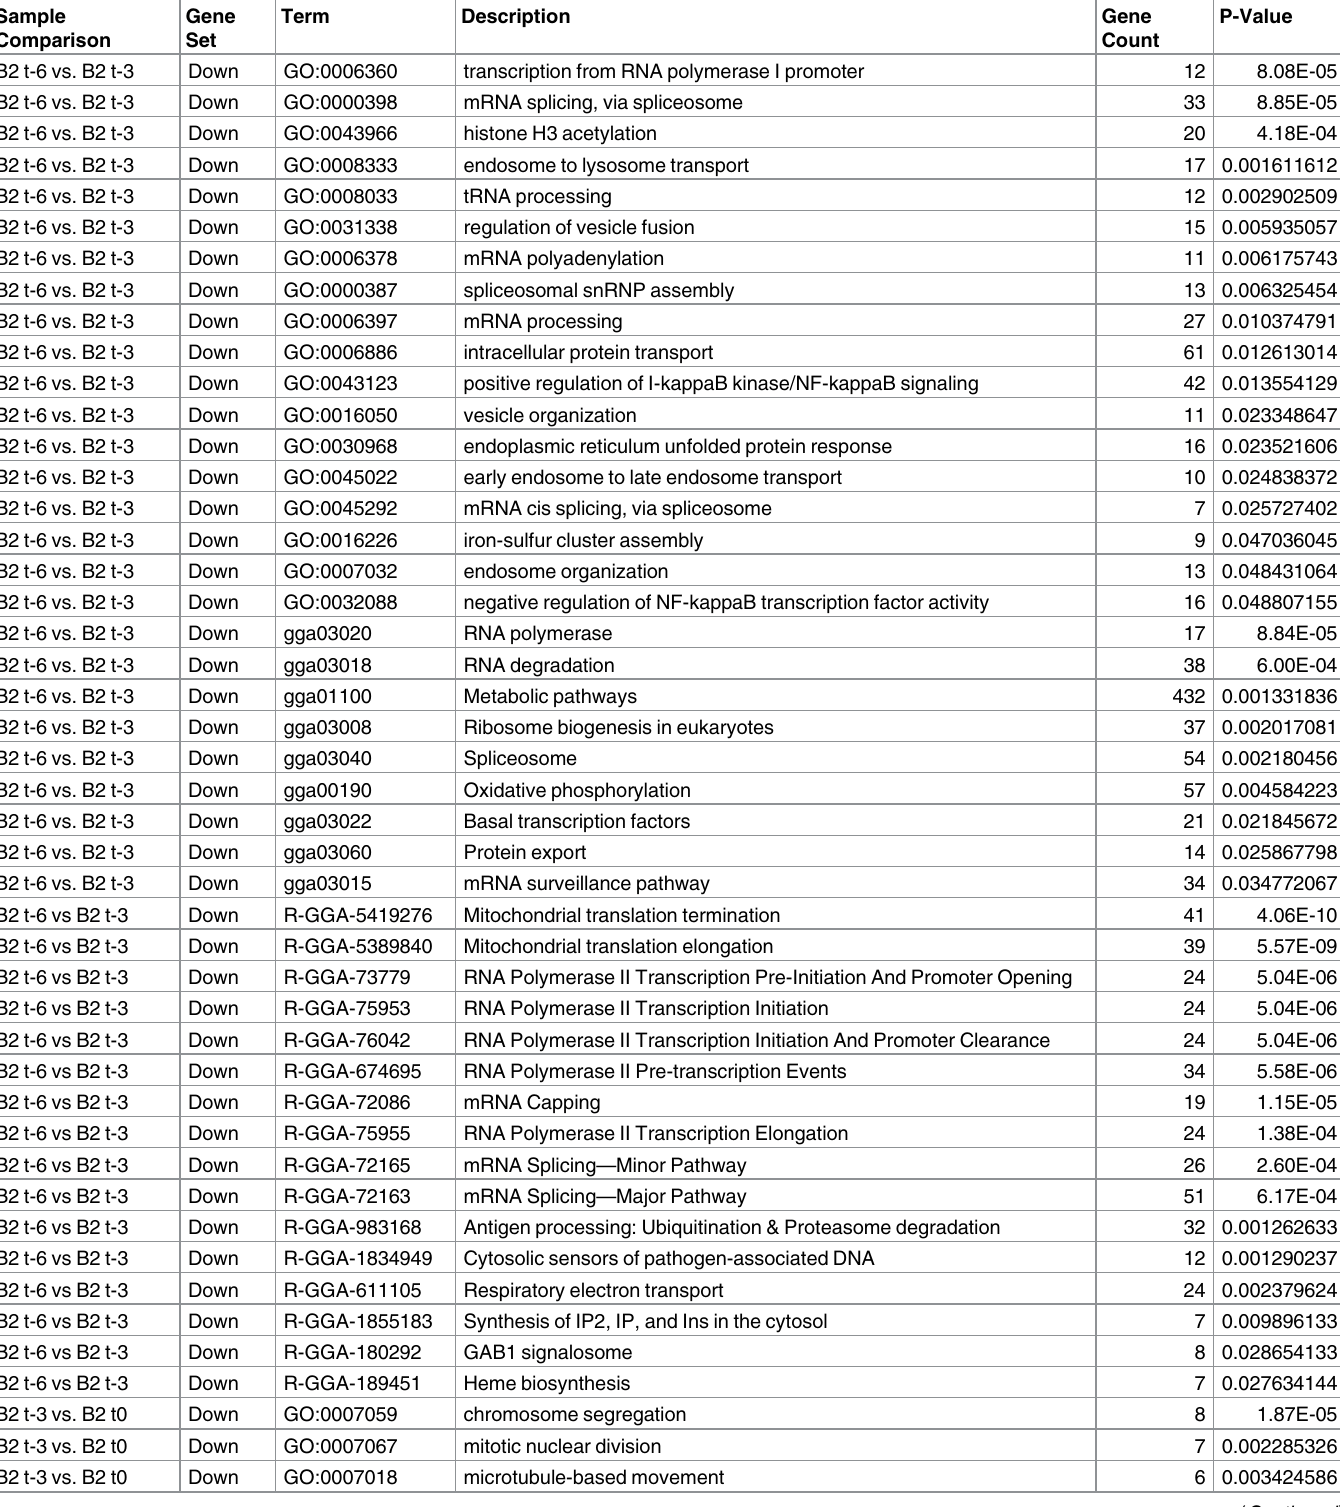
Table 3. Gene enrichment analysis—Highlights from gene ontology, KEGG pathways, reactomepathways. Sample